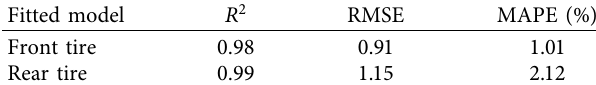
Table 2: Parameter of the BP-NN model. Table 3: Error analysis of the approximation